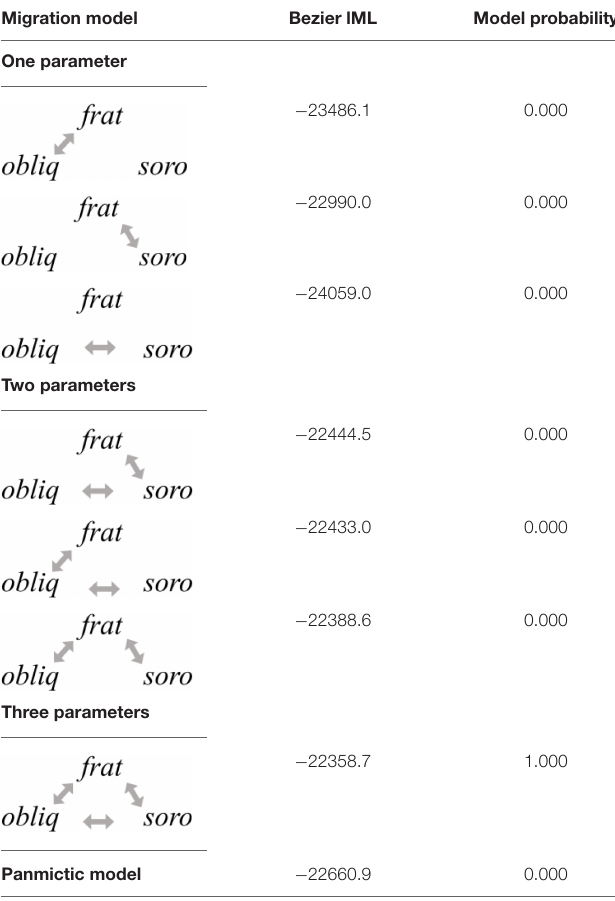
TABLE 5 | Log marginal likelihoods and posterior probabilities calculated through Bayes factors for migration models tested by MIGRATE using data set of 20 loci. Migration model Bezier lML Model probability One parameter −